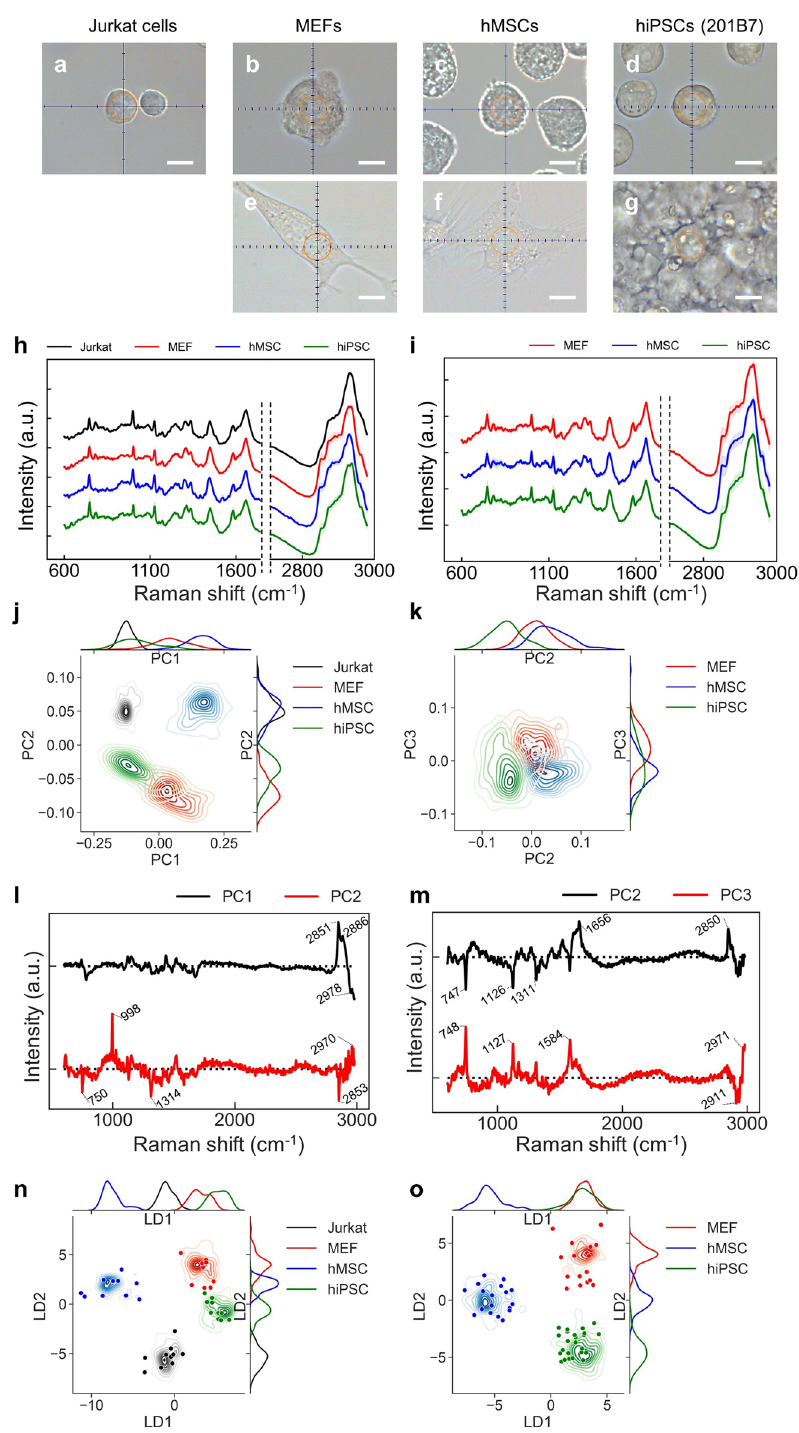
Figure 3. Classification of three or four typical cell types by PRESS. ( a – g ) Bright field image of Jurkat cells, MEFs, hMSCs, and hiPSCs. ( a – d ) Measurement of cells in suspension (a circular area of 10 μm diameter). ( e – g ) Measurement of adherent cells (a circular area of 10 μm diameter). Scale bar: 10 μm. ( h , i ) Average Raman spectrum measured by PRESS for each cell type (Jurkat: black, MEFs: red, hMSCs: blue, hiPSCs: green). SDs are shown by the shaded deviation. ( h : cells in suspension, i : adherent cells). ( j , k ) Kernel density distribution of the PC axes for each cell type. On the x- and y-axes, each cell type distribution density is shown as lines. ( j : cells in suspension (PC1, PC2), k : adherent cells (PC2, PC3)). ( l , m ) The loading vectors calculated by PCA. ( l : cells in suspension (PC1, PC2), m : adherent cells (PC2, PC3)) ( n , o ) Kernel density distribution and scatter plot of LDA score along the first and second liner discriminant (LD1, LD2) axes for each cell type. Kernel density distribution shows training data, while scatter plot shows test data. On the x- and y-axes, the distribution density of each cell type in the training data for LD1 or LD2 is shown as lines. ( n : cells in suspension, o : adherent